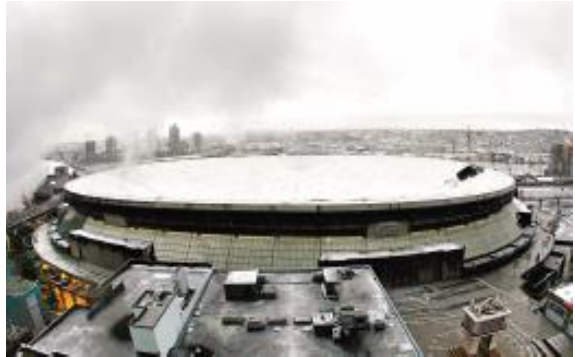
Figure 1. Vancouver Winter Olympic Stadium.